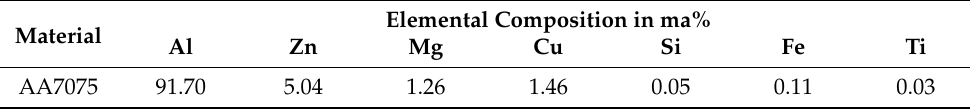
Table 1. Mass fractions of alloying elements of the starting powder AA7075 measured via energy- dispersive X-ray